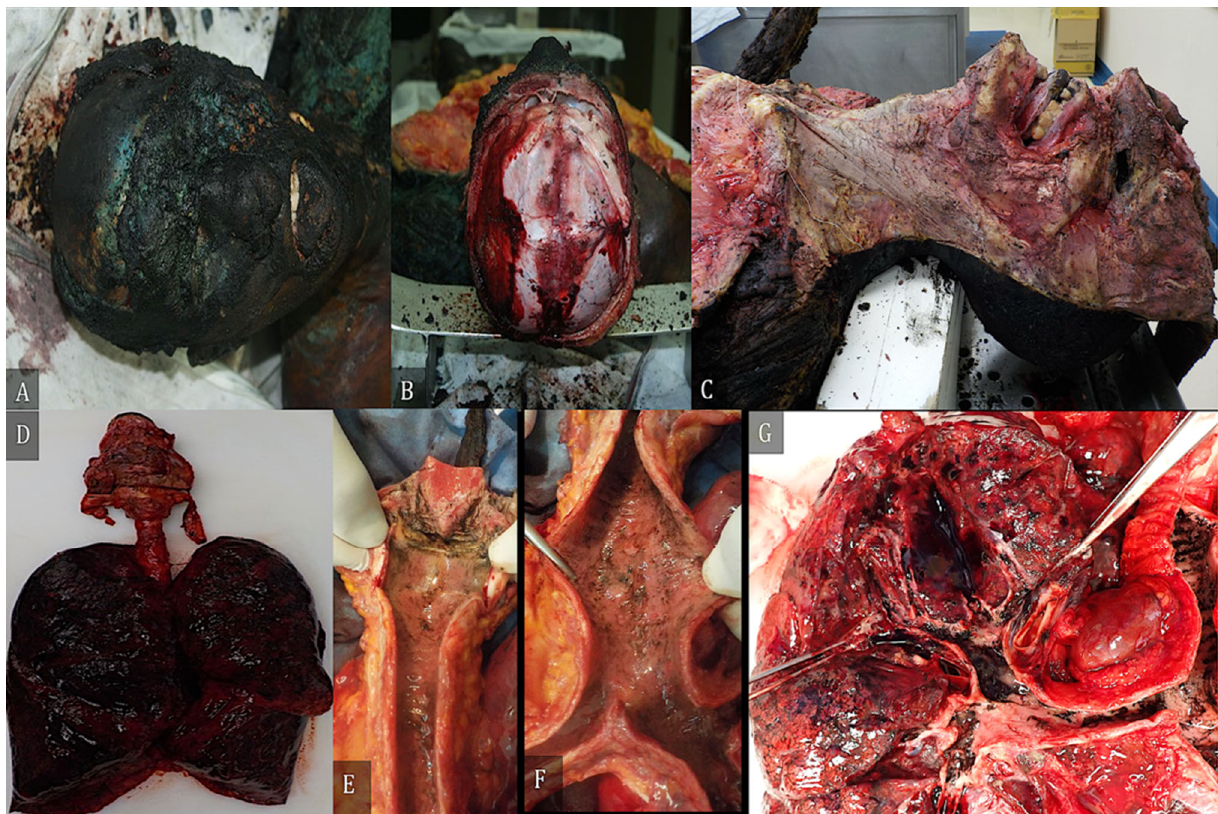
Figure 8. ( A ) Skull of a charred subject, with the tongue, covered with a blackish patina at the tip, protruding from the oral cavity and wedged between the dental arches. ( B ) At the opening of the cranial box, on the inner side of the intact skullcap, we see the presence of a thin extradural hematoma in the left frontoparietal region. ( C ) Layer by layer dissection of the neck that appears non ‐ flamed injured at the level of muscles. ( D ) Example of airway removed “en bloc”, i.e., after isolation of the esophagus and thoracic aorta, careful dissection “en bloc” of the tongue, soft palate, pharynx, hyoid bone, larynx, trachea, bronchi, and lungs was performed. ( E , F ) The trachea and bronchi show edematous and hyperemic cherry red mucosa with sooty residue inside; ( G ) Detail of main bronchi showing edematous and hyperemic mucosa and sooty fragments.